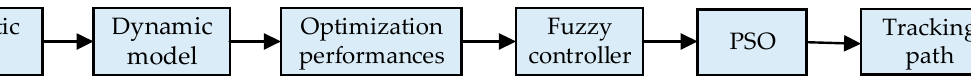
Figure 1. The technology roadmap for AUV path tracking.